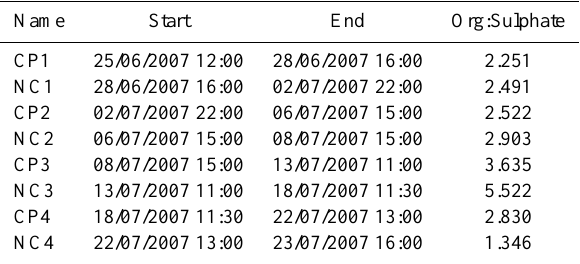
Table 1. Time and date for “cloud periods” (CP) and “no-cloud” (NC) periods as defined by RH and GRIMM measurements, and the Organic:Sulphate ratio for each